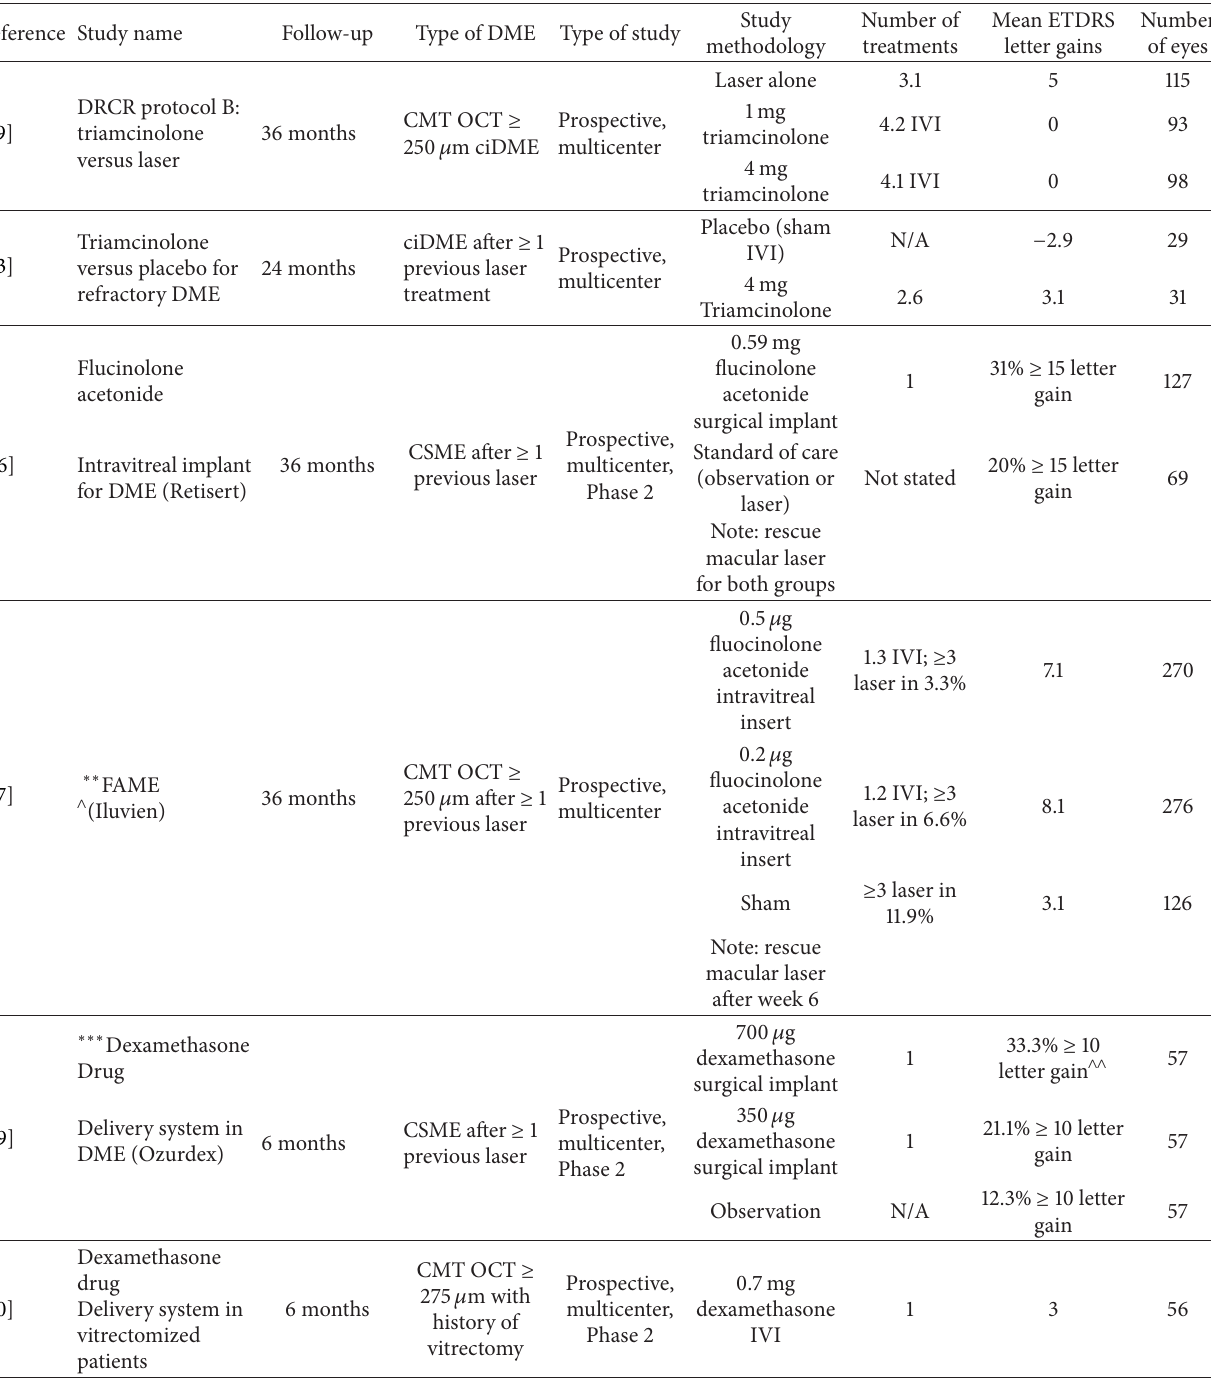
Table 2: Summary of major studies evaluating corticosteroids for